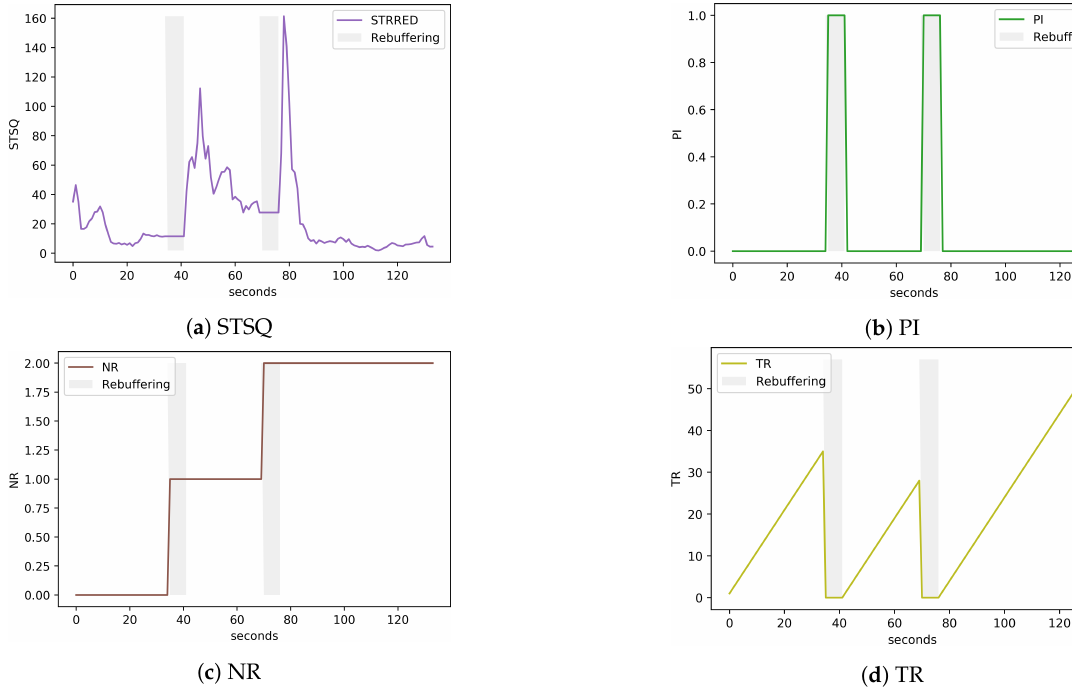
Figure 1. Example of rebuffering and bitrate-related features represented by STSQ, PI, NR, and